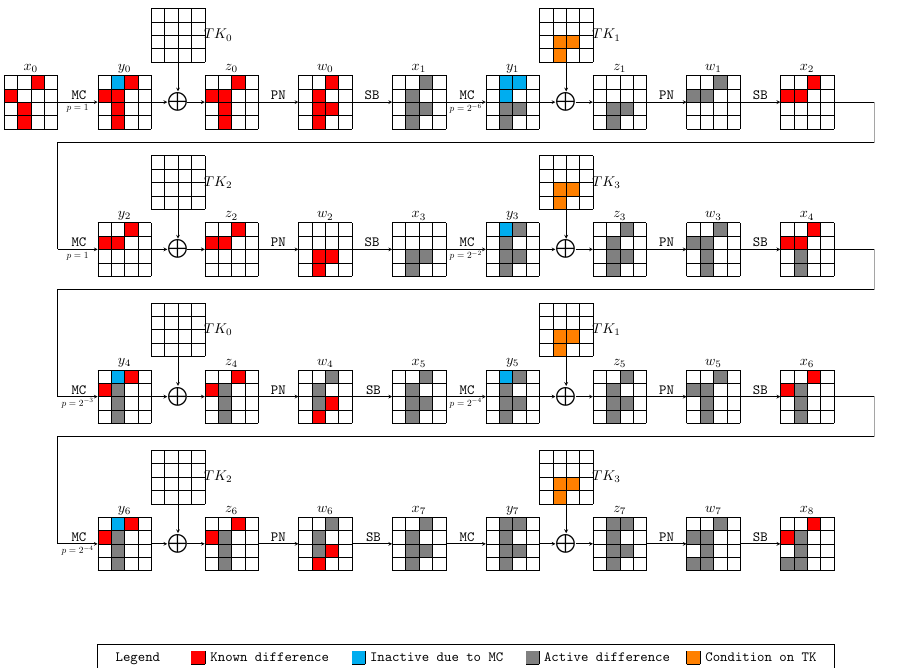
Figure 11: An 8-round truncated differential trail of CRAFT with probability 2 −